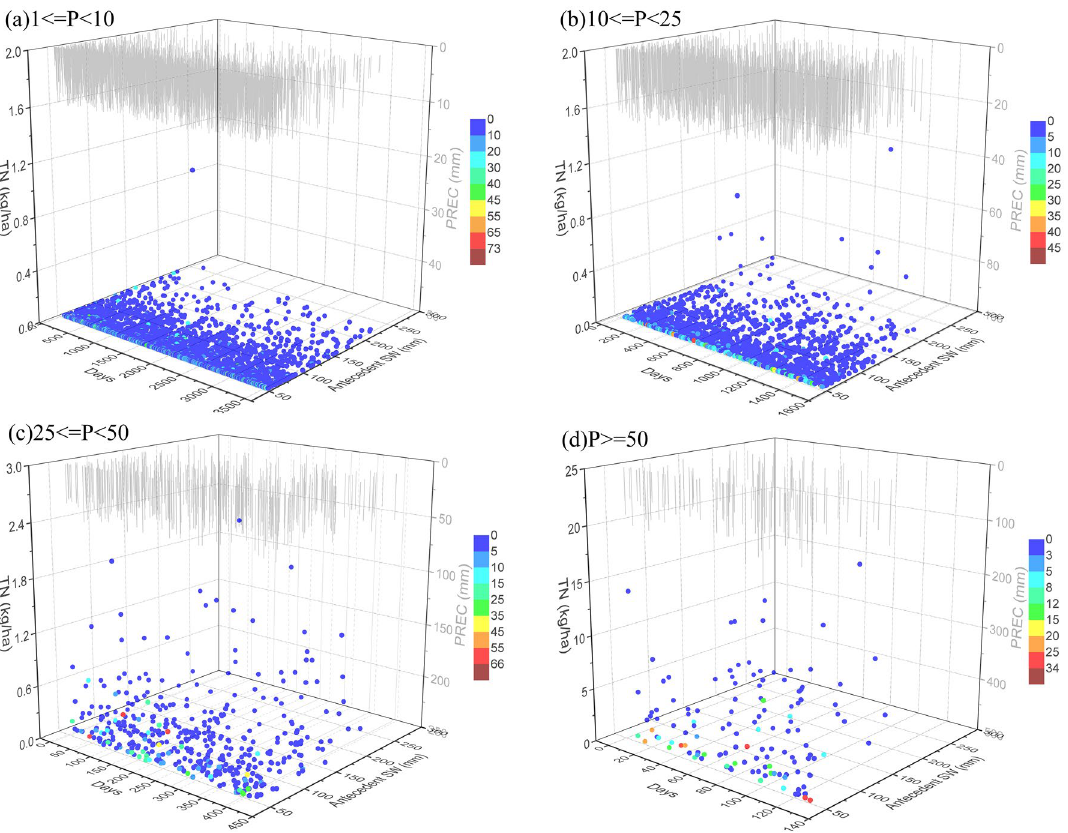
Figure 9. Relationship of TN load with precipitation (PREC, mm), antecedent drought days, and antecedent soil water (antecedent SW, mm) at different precipitation amounts: ( a ) light rain (1 ≤ P < 10 mm), ( b )